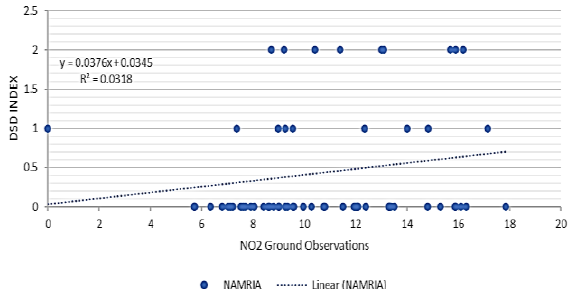
Figure 15. Ground-based observations of NO 2 plotted against the DSD Index at the NAMRIA station in Taguig City.